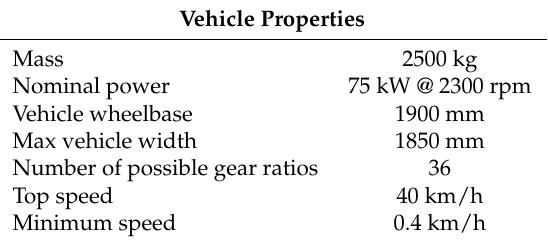
Table 1. Main characteristics of the orchard